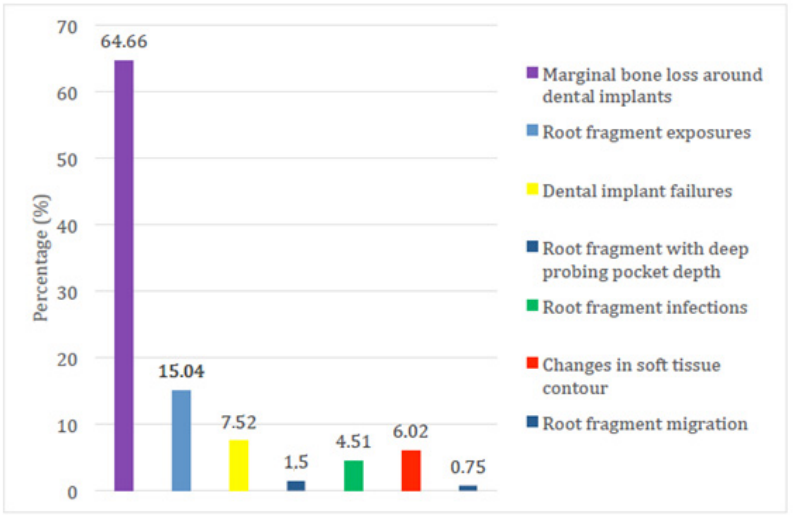
Figure 2. The frequency and percentage distribution of the dental implant failures and complications and undesired adverse effects of immediate dental implant placement in conjunction with the socket-shield technique of the included clinical studies. Bone loss as mentioned in the result section has been reported but considered inevitable. Table 3. The quantitative description of the total number of clinical studies included in the present and complications in conjunction with the socket-shield technique. Number of Clinical Studies